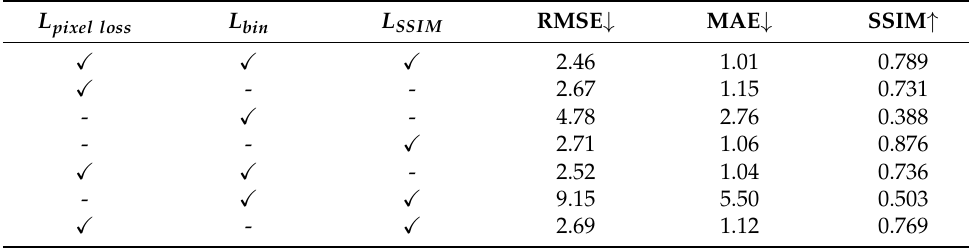
Table 6. Different loss term of experimental